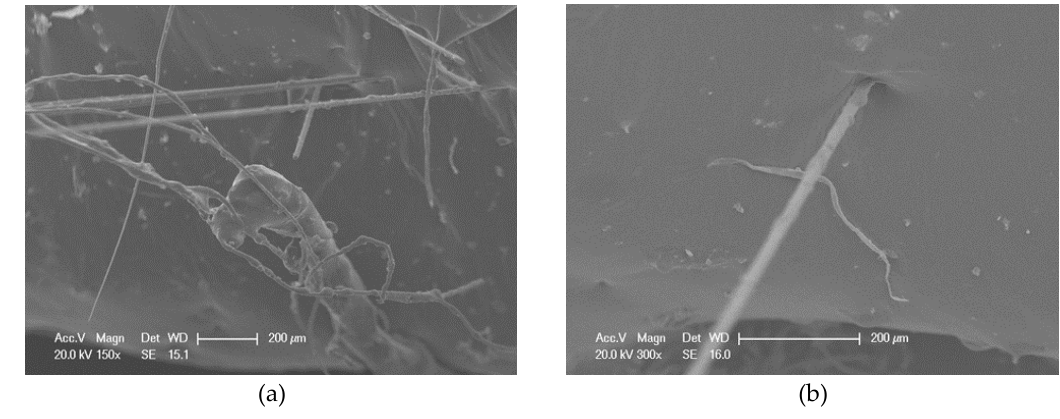
Figure 17. Micro images of MFRA (1.5:1.5): ( a ) image 1, 150×; ( b ) image 2, 300×.